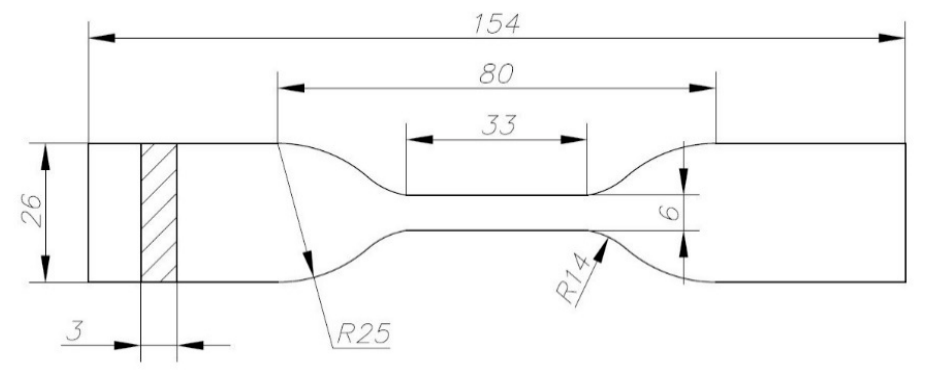
Table 2. Characteristics of the fused filament fabrication (FFF) process.